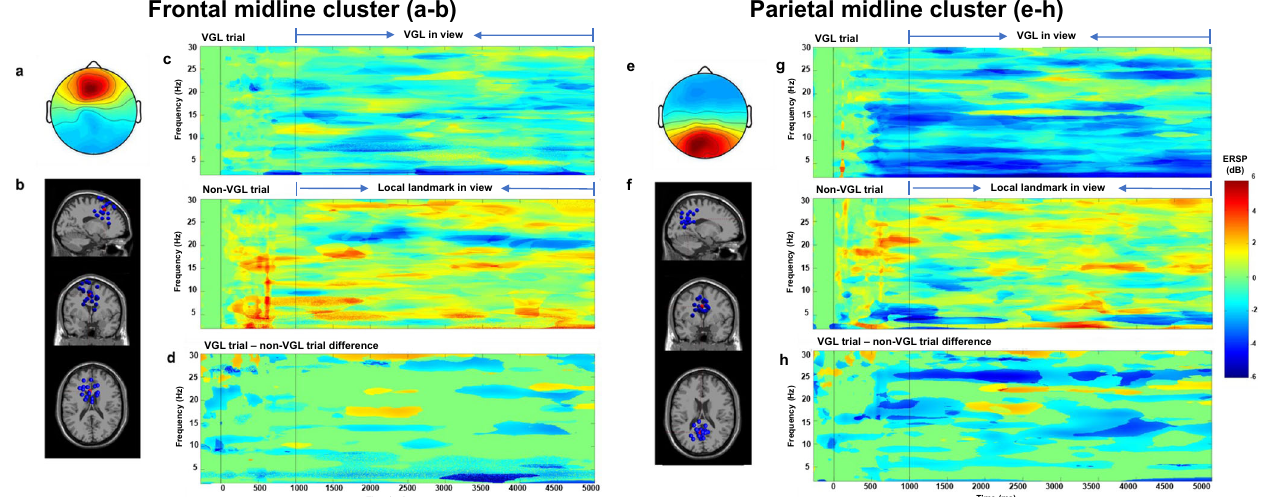
Fig. 4 Frontal midline cluster (left, MNI coordinates x = − 4, y = 19, and z = 43) and parietal midline cluster (right, MNI coordinates x = − 4, y = − 52, and z = 30). a , e Scalp maps for frontal ( a ) and parietal ( e ) midline clusters. b , f Equivalent dipole locations of independent components (in or near the frontal ( b )/parietal ( f ) cortex) at the sagittal, coronal, and top view, respectively. c , g ERSPs in VGL and non-VGL trials from frontal ( c ) and parietal ( g ) midline clusters ( fi rst dotted lines at the 0 ms time point signify the onset of a trial, and the second dotted lines at the 1000 ms time point signify the onset of stimuli). d , h Signi fi cant differences between midline clusters in the two trial conditions (ERSPs of VGL trials minus the ERSPs of non-VGL trials) with p < 0.001 for the frontal ( c ) and parietal ( g ) cortices. For all ERSPs, non-signi fi cant points were masked with zero values in the mean ERSPs and are displayed in green. Signi fi cant differences with respect to baseline activity are displayed in red and blue for positive and negative deviations from the baseline activity,